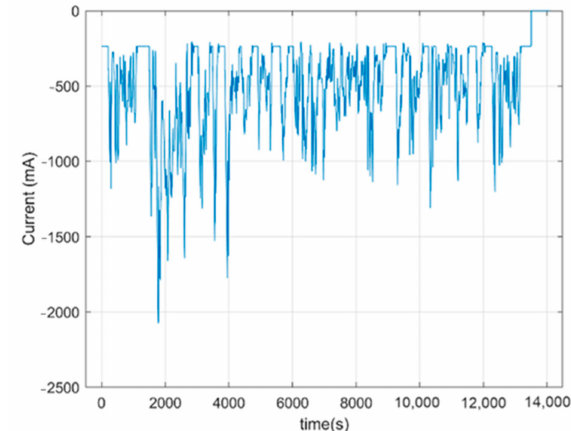
Figure 13. Current waveform of UDDS working condition.